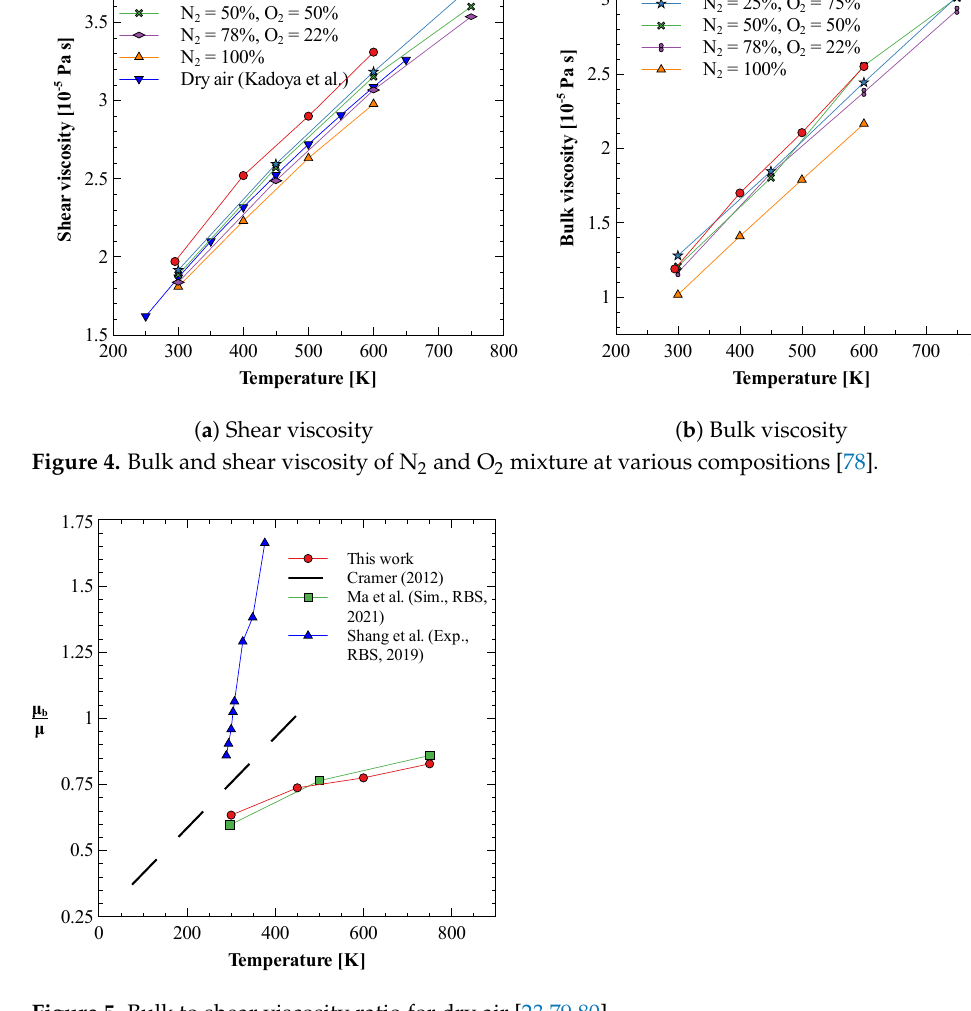
Figure 5. Bulk to shear viscosity ratio for dry air